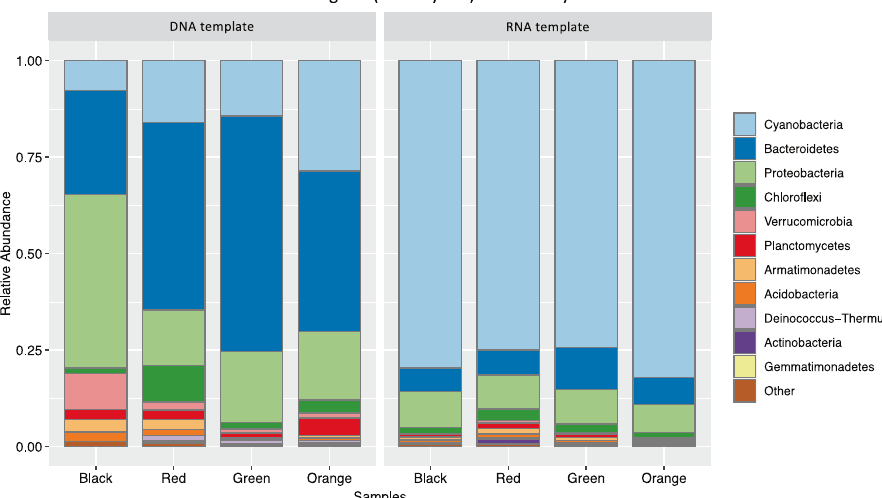
Fig. 3 Template dependent community structuring. Comparison of prokaryote relative abundances using single data points collected from 01/28/17 black, red, green and orange mats showing differences between 16S rDNA community sequenced from DNA vs RNA